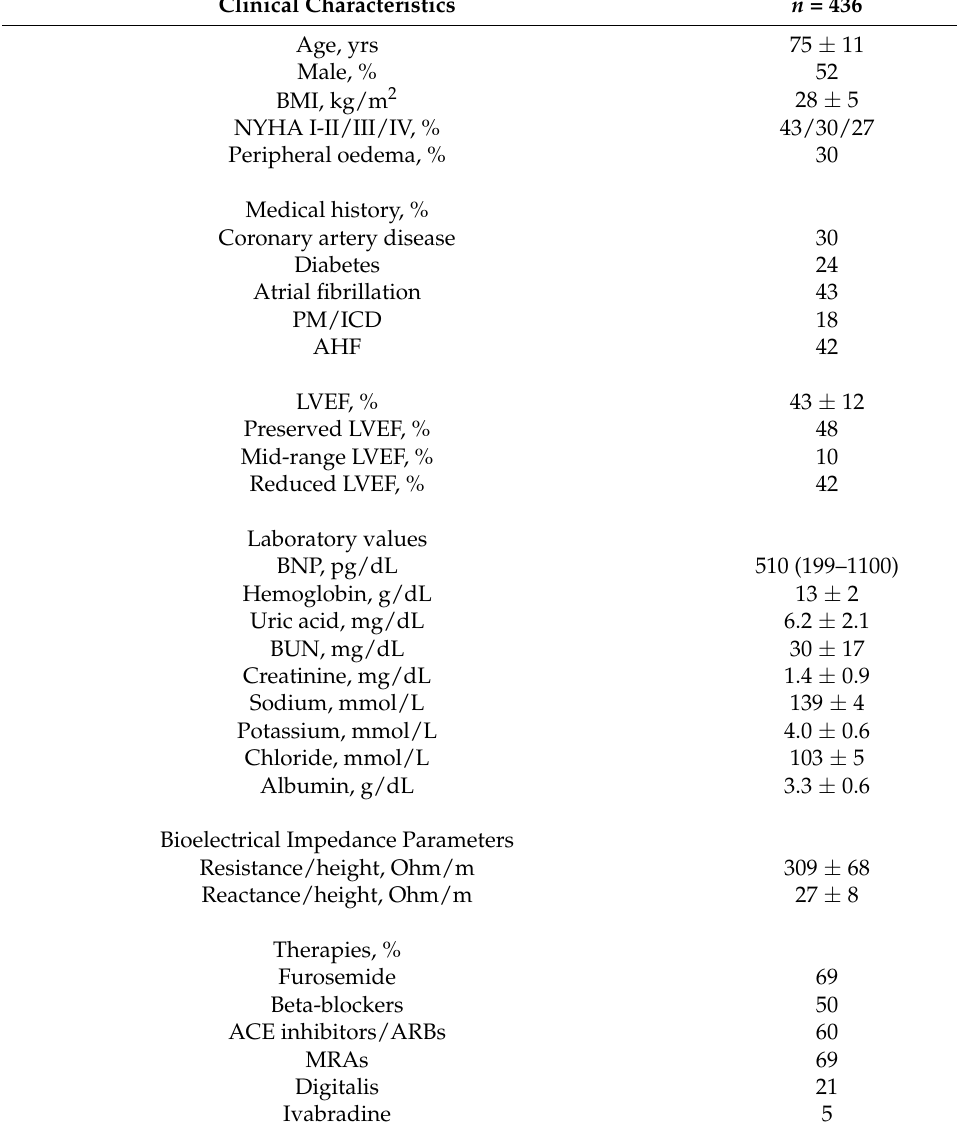
Table 1. Patient characteristics.